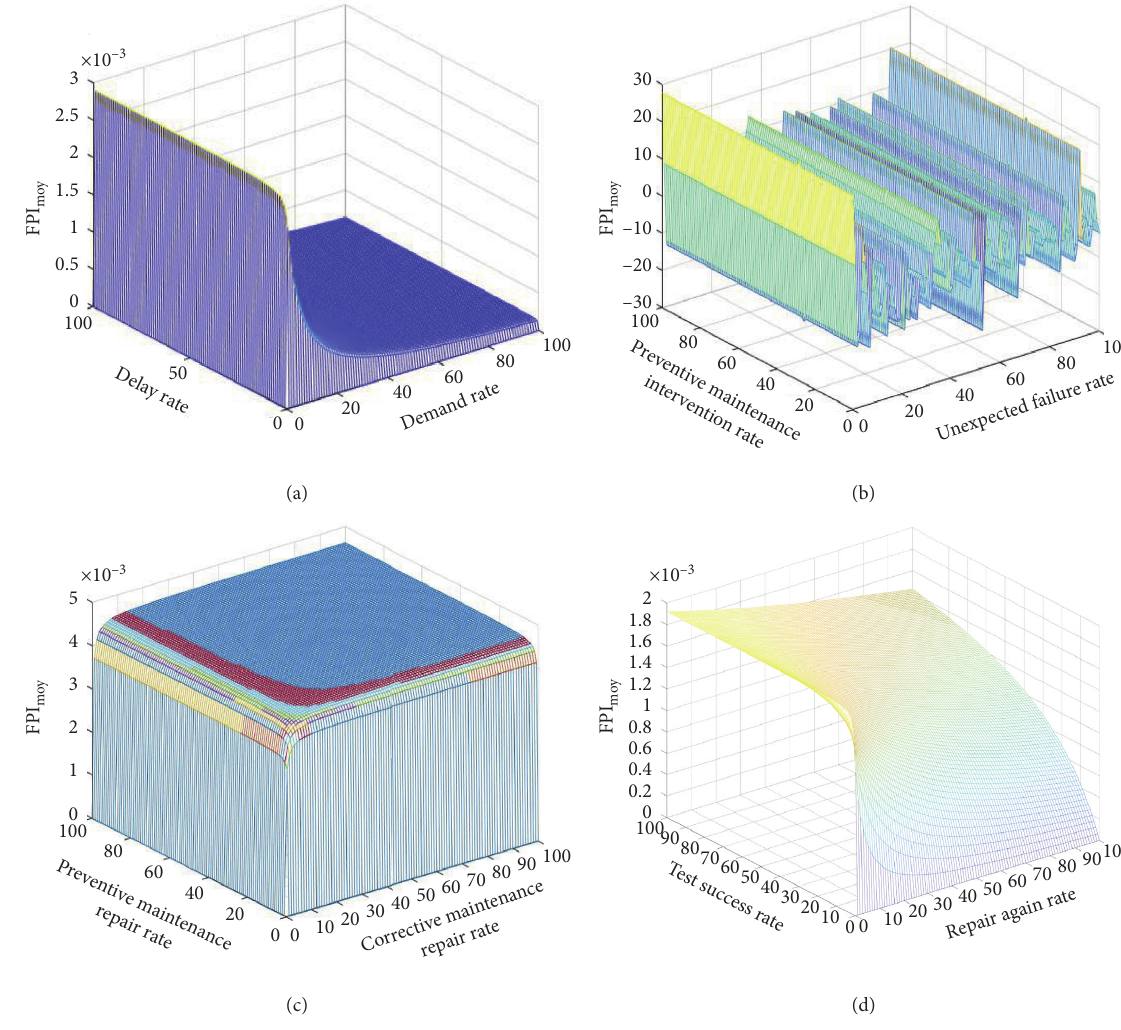
Figure 8: Interventions for unexpected failures. (a) Variation of demand and delay rates. (b) Rate variation of unexpected failure and maintenance interventions. (c) Repair rate variation for corrective and preventive maintenance. (d) Test rate variation (repair again or